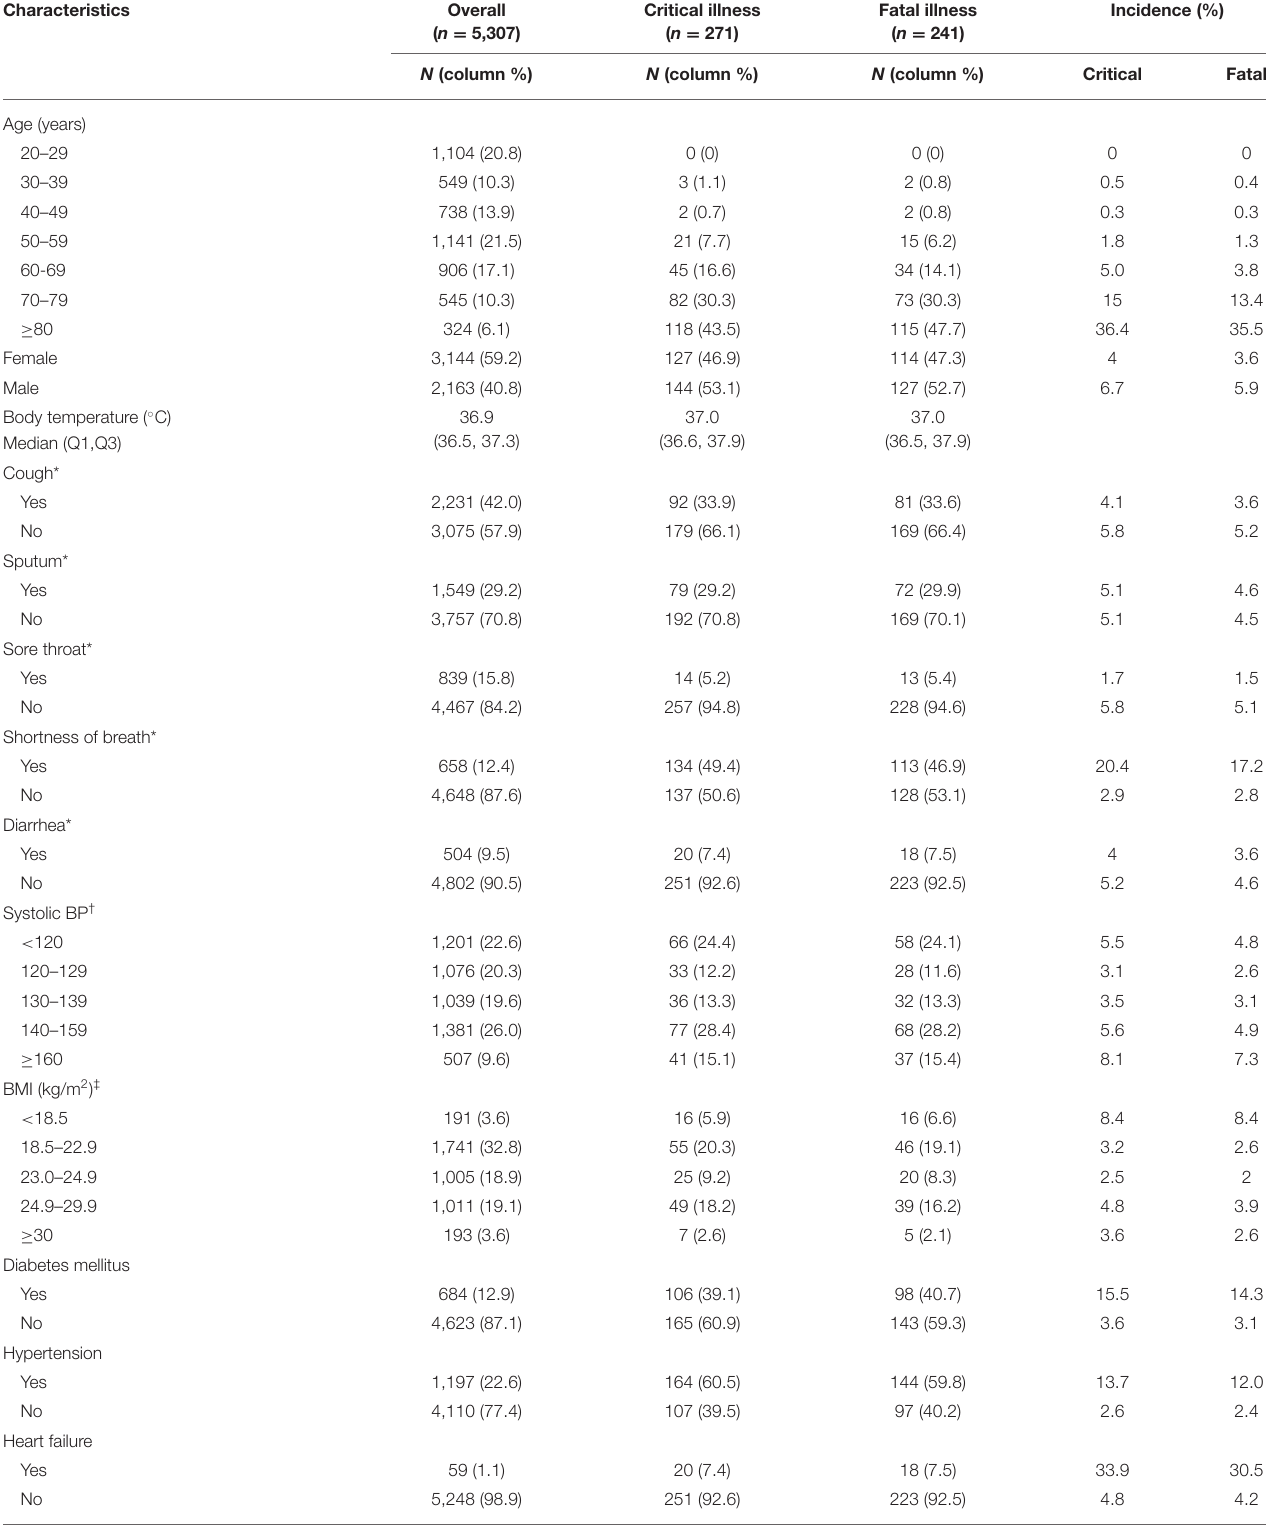
TABLE 1 | Baseline characteristics of the study population.